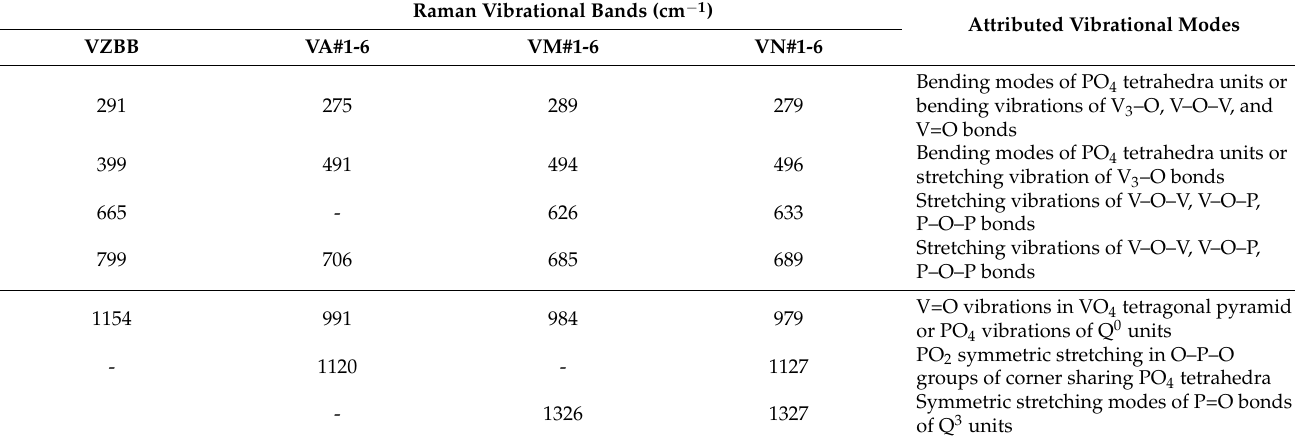
Figure 6. Comparison of the Raman spectra in 55V 2 O 5 -5ZnO-22BaO-3B 2 O 3 -15M(PO 3 ) n (where M = Al, Mg, Na, n = 3, 2, 1, respectively, mol%) glass system and 70V 2 O 5 -5ZnO-22BaO-3B 2 O 3 glass system. Refer to Table 1. Table 3. Assignment of observed Raman bands of V 2 O 5 -5ZnO-22BaO-M(PO 3 ) x -3B 2 O 3 (where M = Al, Mg, Na, n = 3, 2, 1, respectively, mol%) glasses.